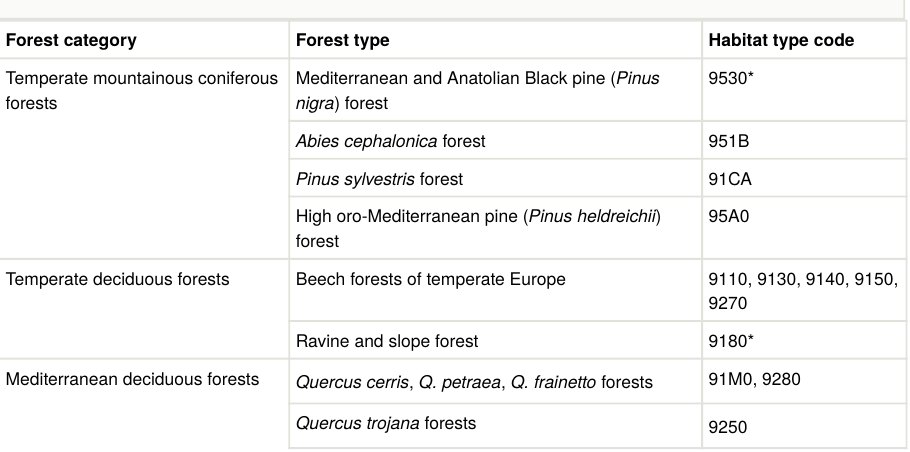
Forest categories and types of Greece (Dimopoulos et al. 2014) in correspondence with the assessed habitat types; the habitat type codes of Greek interest are underlined; asterisk (*) indicates habitat types of conservation priority in